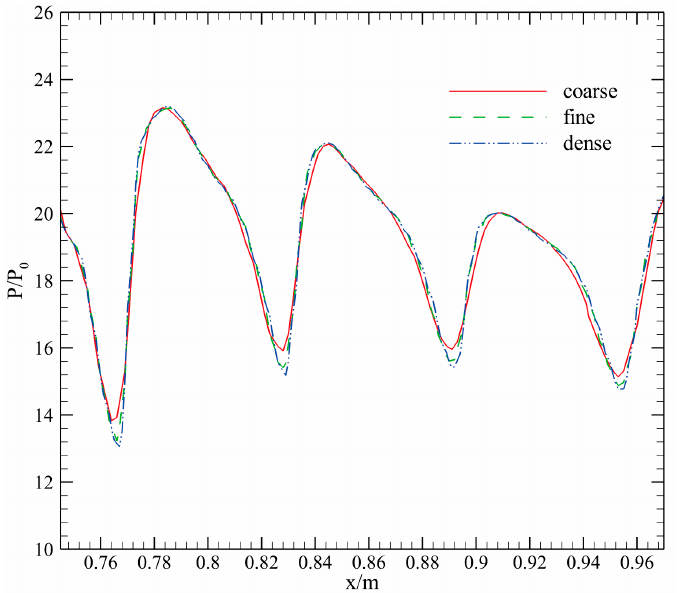
Figure 5. Comparison of the computed outer-wall pressure distribution for the three grid densi-